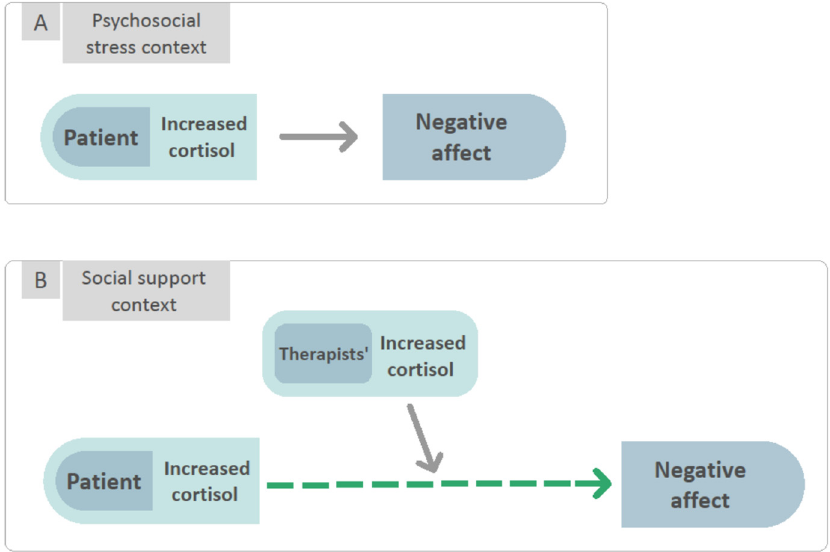
Figure 1. In line with our hypotheses, when in the context of psychosocial stress, there exists an association between increased patient cortisol levels and negative affect. Alternatively, when in the context of social support, the association between increased cortisol levels and negative affect is diminished when the therapist exhibits increased cortisol levels as well. Psychosocial stress context ( A ) is defined as an interpersonal situation that results in increased cortisol levels. Social support context ( B ) is defined as the empathic stress response of the other in an interpersonal situation.